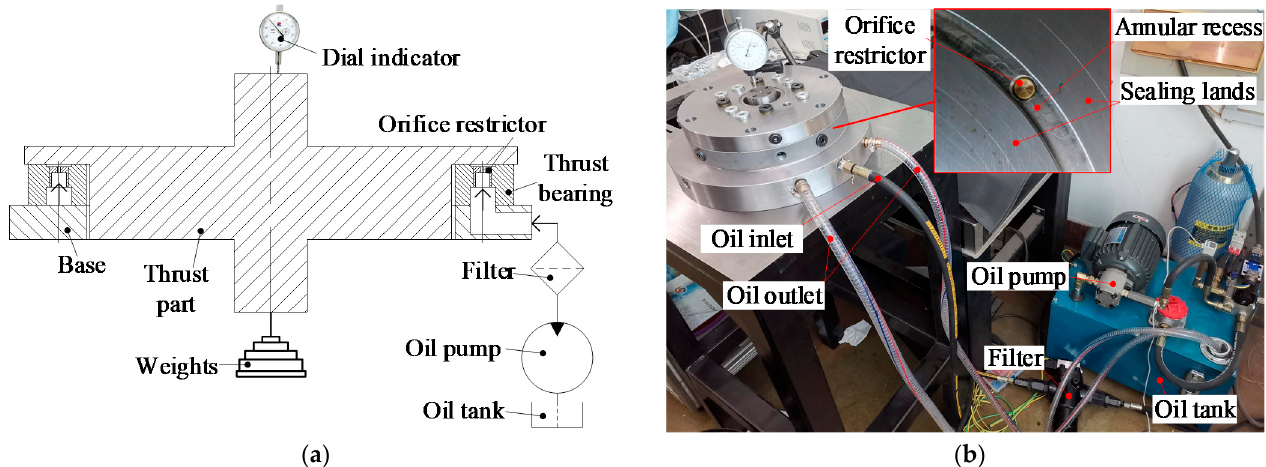
Figure 14. Experimental bench of the hydrostatic thrust bearing with OLDR of 2. ( a ) Schematic diagram of the test rig; ( b ) experimental setup.